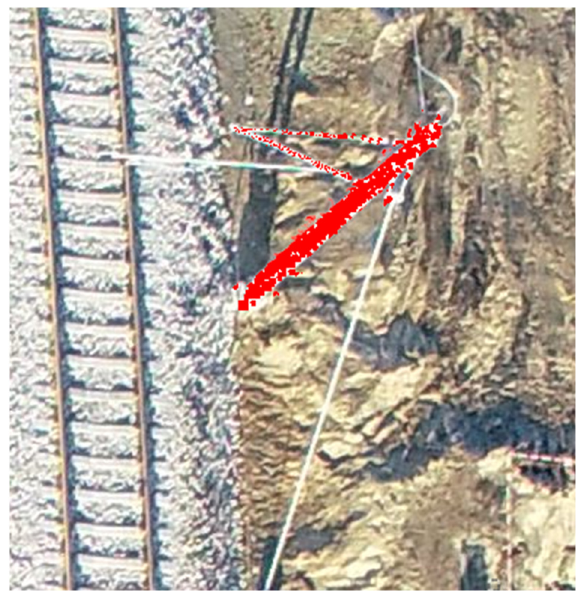
Figure 7. An example of projecting a point cloud into a photo.